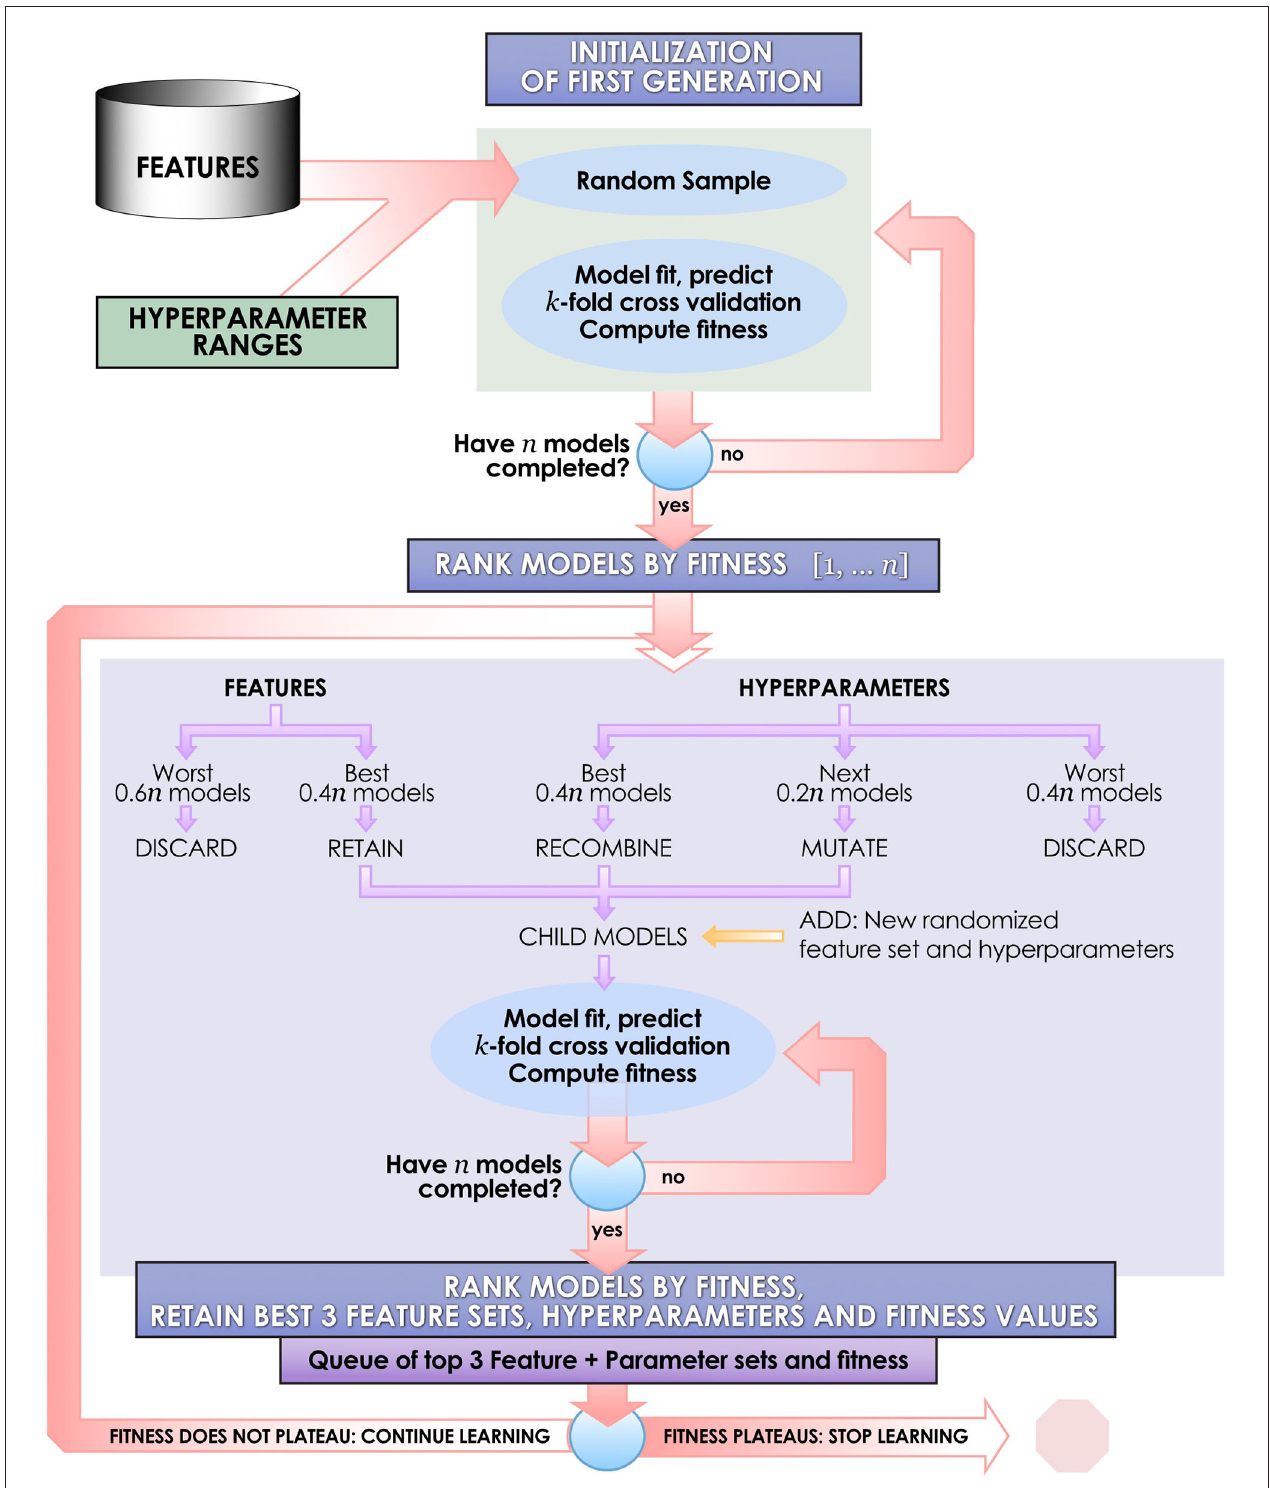
FIGURE 3 | Schematic of the IEL learning process. IEL is an example of a narrow AI algorithm that acts upon a machine learning technique, designed for discovery science in large datasets. IEL is used to jointly learn features and hyperparameter settings for machine learning models in an integrated, adaptive manner over successive learning generations in response to new inputs on the basis of an information theoretic fitness function.